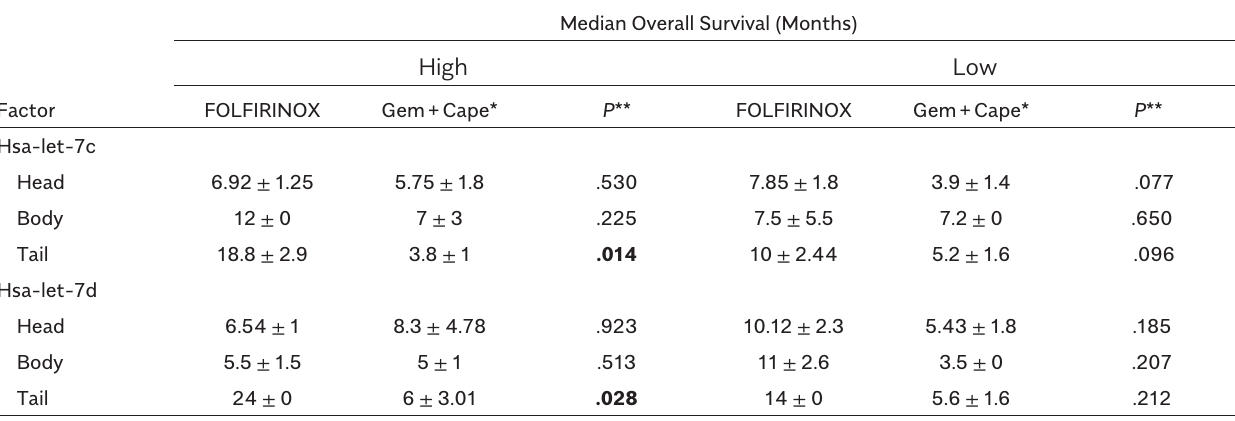
Table 4. The Relationship Between Median Overall Survival and Anatomical Origin of Pancreatic Cancer in Low- and High-Level Serum Let-7c and 7d with FOLFIRINOX and Gemcitabine + Capecitabine Treatment